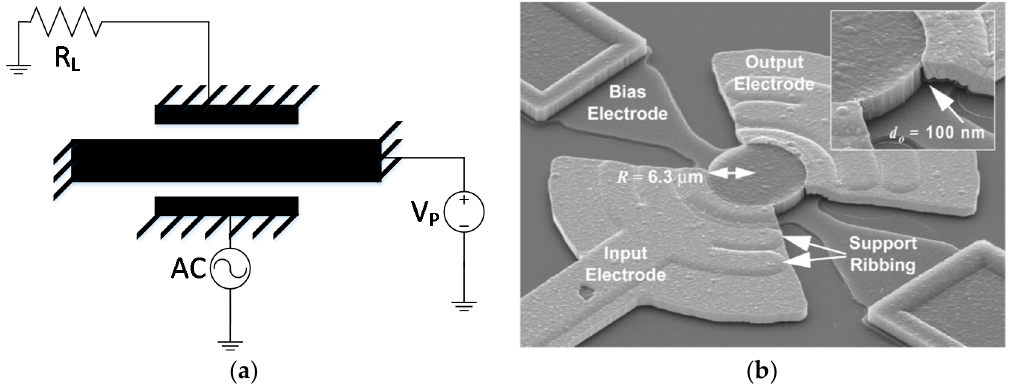
Figure 15. The schematic representation of a two-port capacitive beam resonator ( a ) and the scanning electron micrograph of a capacitive polysilicon disk resonator ( b ) [62]. © 2005 IEEE. Reprinted with permission from High-Q UHF micromechanical radial-contour mode disk resonators by J.R. Clark in J. Microelectromech. Syst. , 2005.